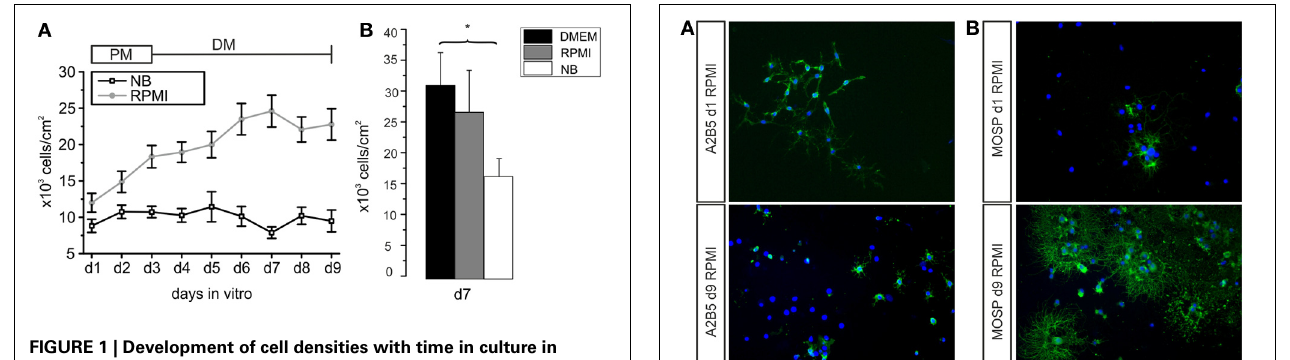
FIGURE 1 | Development of cell densities with time in culture in different basal media. (A) Oligodendrocyte precursor cell cultures incubated from d1 to d3 in proliferation medium (PM) and for an additional 6 days in differentiation medium (DM) based on NB (black line) or RPMI medium (gray line) after purification. Each data point obtained by counting DAPI-stained nuclei from at least 8 photographed frames per preparation. Note the higher cell number from d1 to d9 [d3 to d9 ( ∗ p < 0 . 05)] in RPMI based medium compared with NB based medium (13 preparations in RPMI and 7 preparations in NB investigated). (B) Comparison of number of cells/cm 2 surviving after 7 days in serum free media differing exclusively in the choice of the basal medium. Note that the highest rate of surviving cells was found in DMEM. ( ∗ p < 0 . 05, error bars indicate ± s.e.m.).